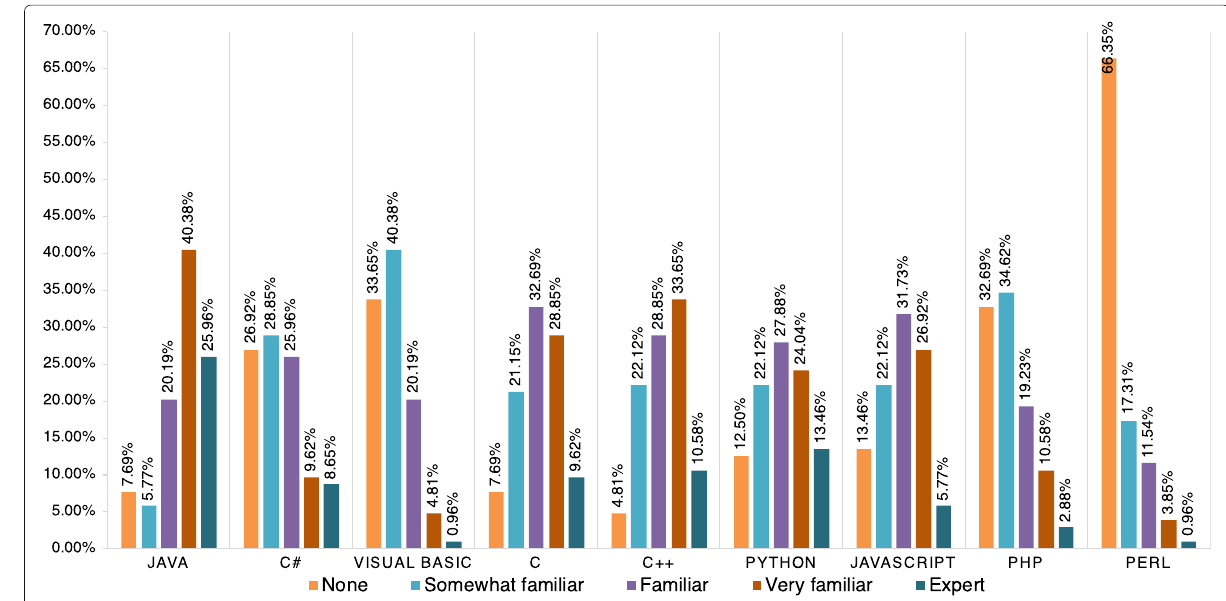
Fig. 5 Participants’ familiarity with programming